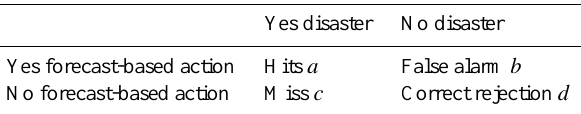
Table 1. Contingency table depicting possible scenarios for forecast-based